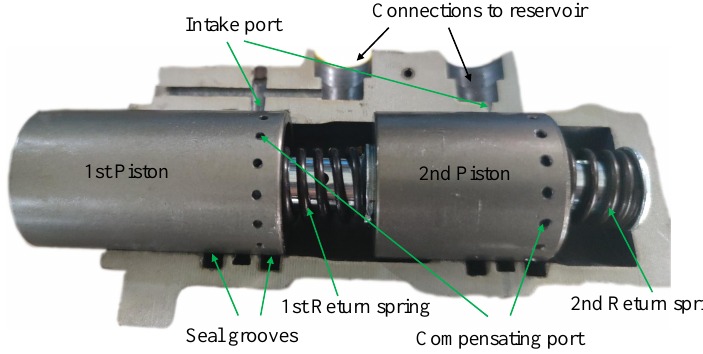
Figure 2. Half-cutaway view of the master cylinder.